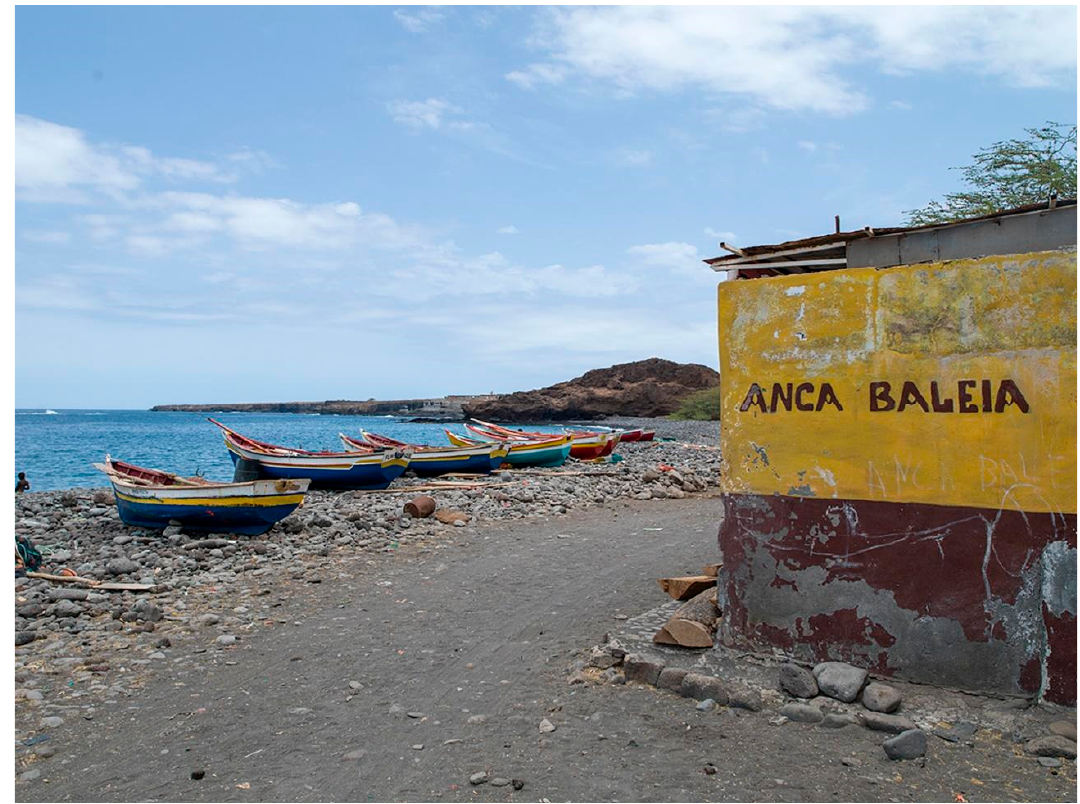
Figure 5. Street wall in Porto Rincão (island of Santiago, Cape Verde) with the inscription “Anca Baleia”. Photographed by Hermano Noronha (2019).